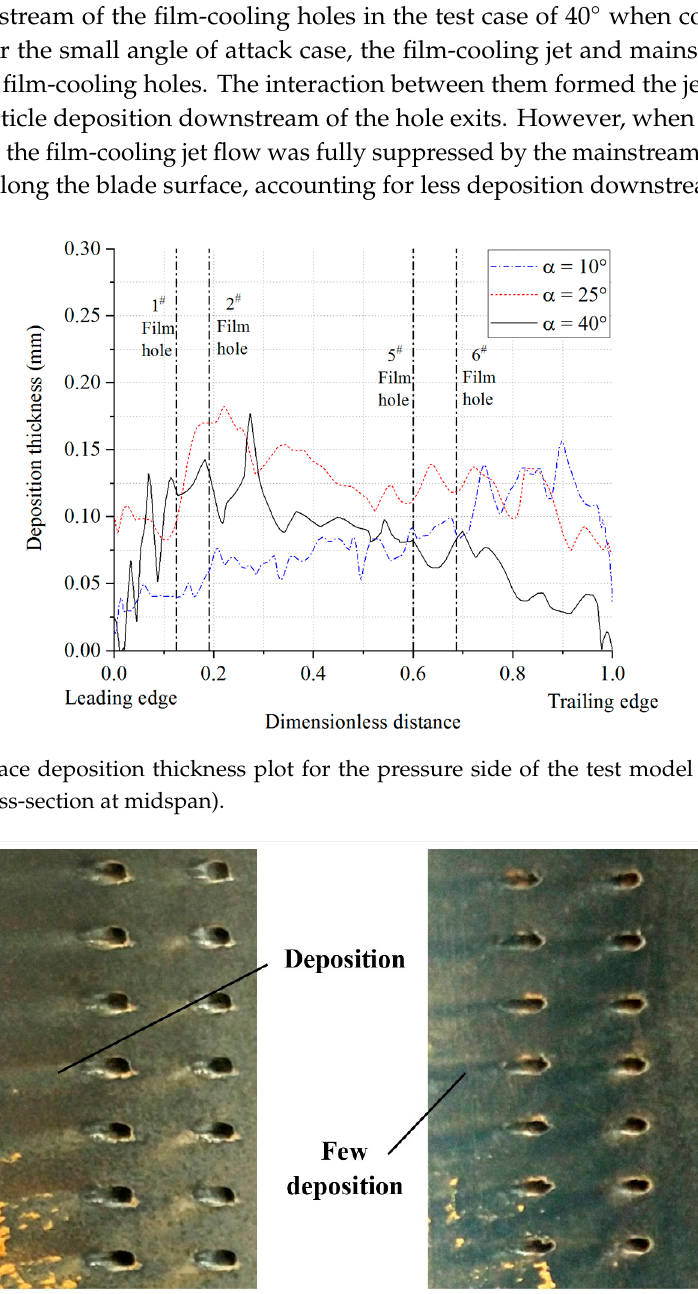
Figure 19. Images of the post-test blade pressure side at the angle of attack: ( a ) 10°, ( b ) 25°, and ( c ) 40°.